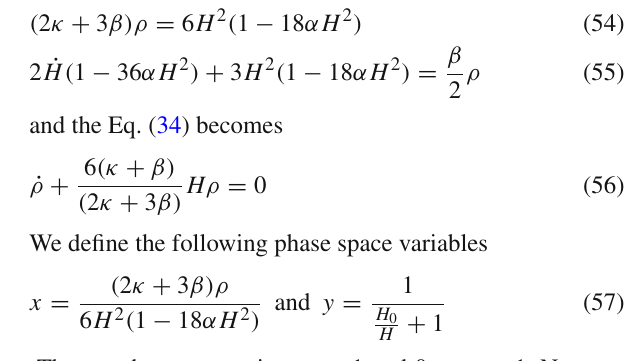
Fig. 1 Phase plots corresponding to the case β = 0 with κ = 1